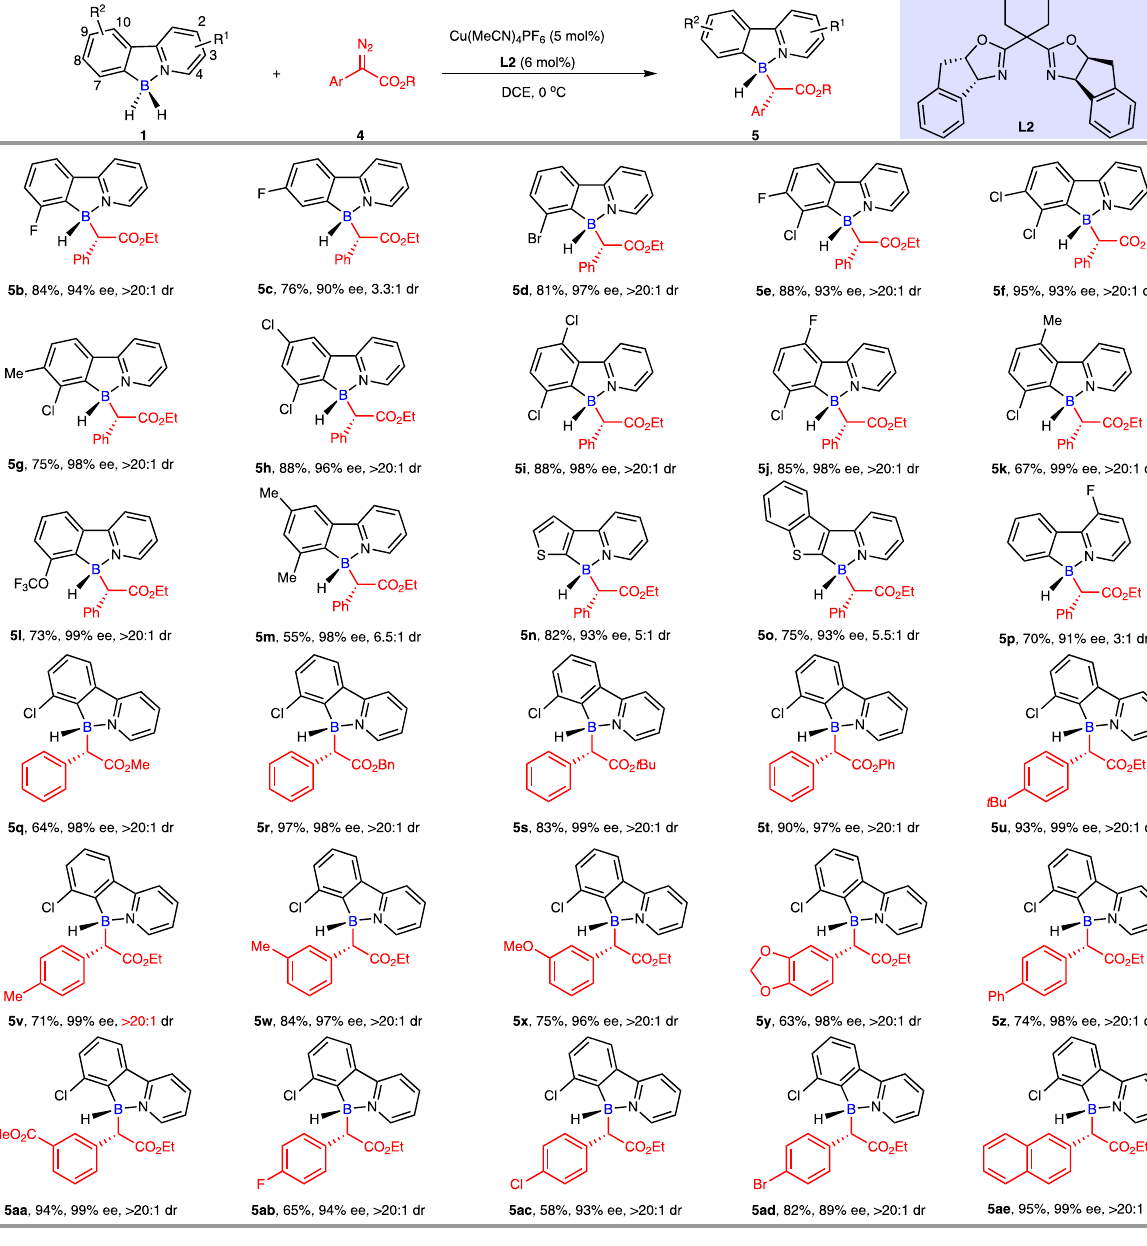
Fig. 7 Substrate scope of 2-arylpyridine-boranes with α -diazoarylacetates. Conditions: a 2-arylpyridine-borane ( 1 ) (0.12 mmol, 1.2 equiv), α - diazoarylacetate 4 (0.1 mmol, 1 equiv), Cu(MeCN) 4 BF 4 (5 mol%), L2 (6 mol%), DCE (1 mL) at 0 °C. b Isolated